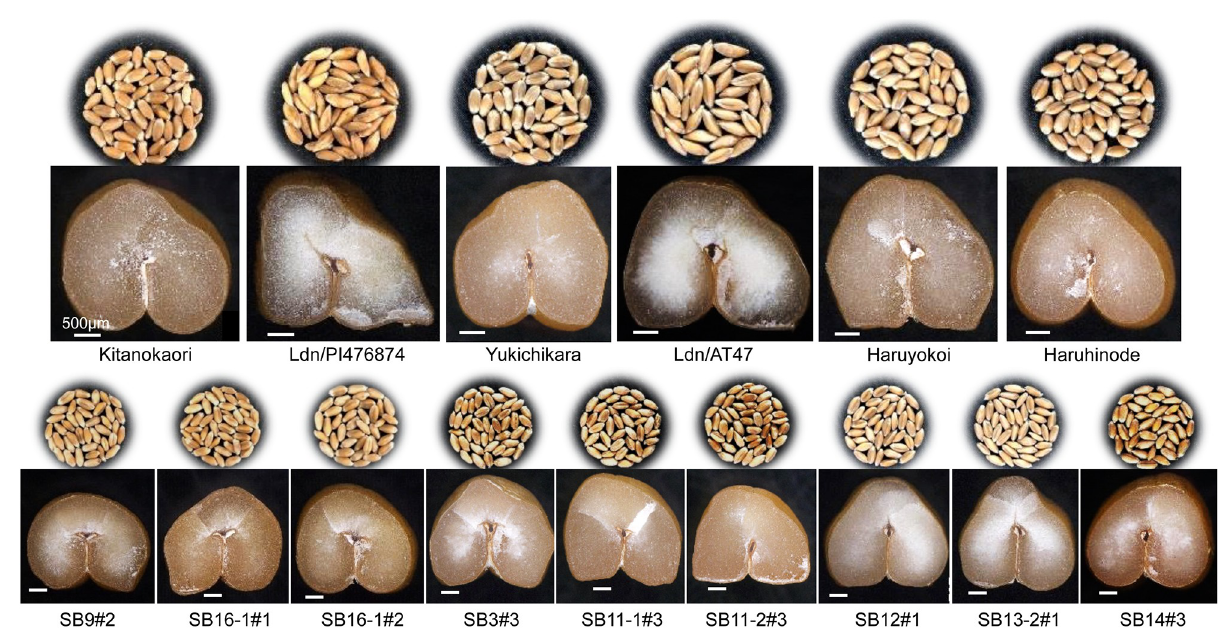
Fig 2. Photos of mature grains and their transverse sections in the selected early heading lines and their parents.